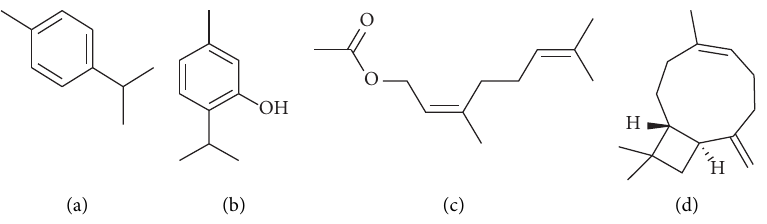
Figure 1: Chemical structures of (a) p -cymene, (b) thymol, (c) neryl acetate, and (d) β